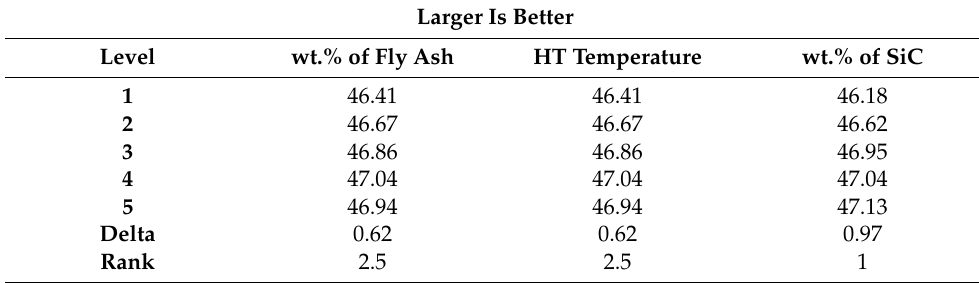
Table 6. Response table for signal-to-noise (S/N) ratios for ultimate tensile strength. Larger Is Better Level wt.% of Fly Ash